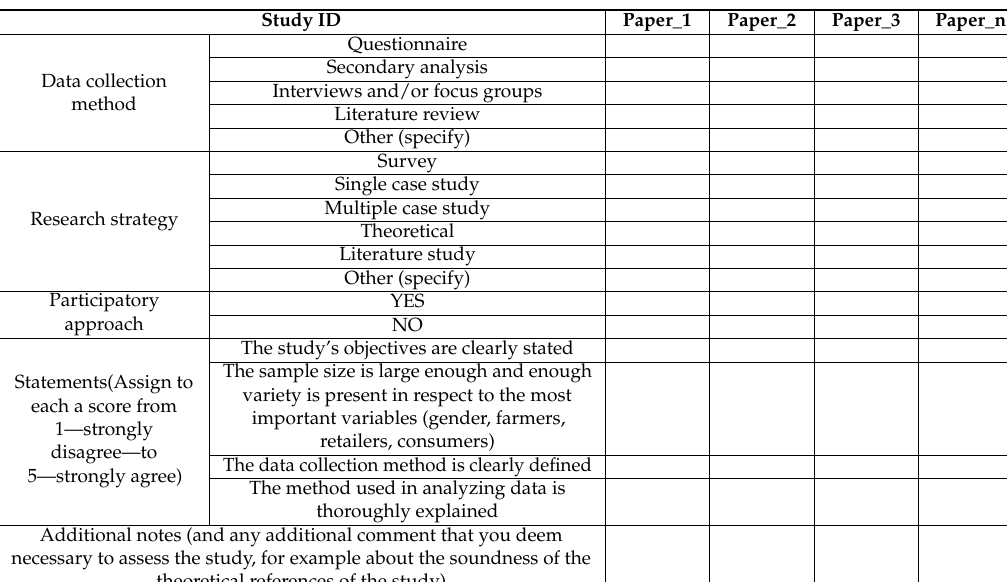
Table A2. Methodological Screening: